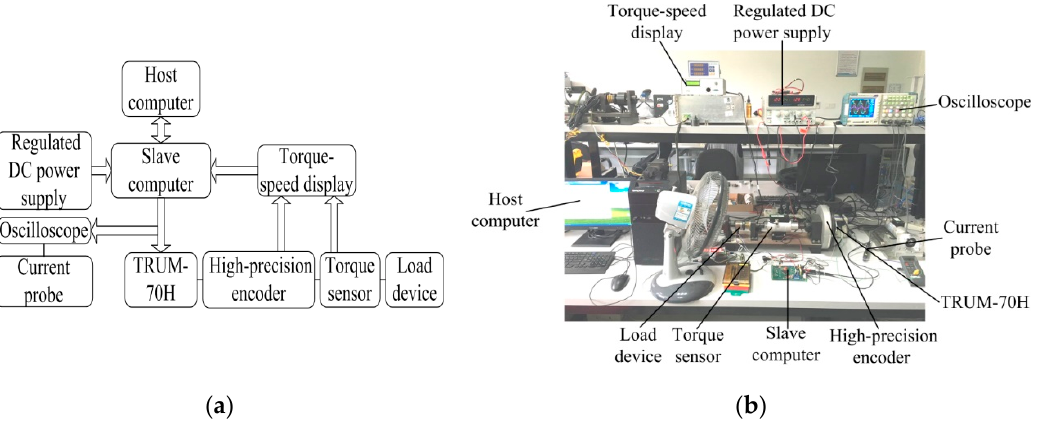
Figure 14. System for testing the mechanical characteristics of TRUMs: ( a ) a principle block diagram of the test system and ( b ) a photograph of the test system.